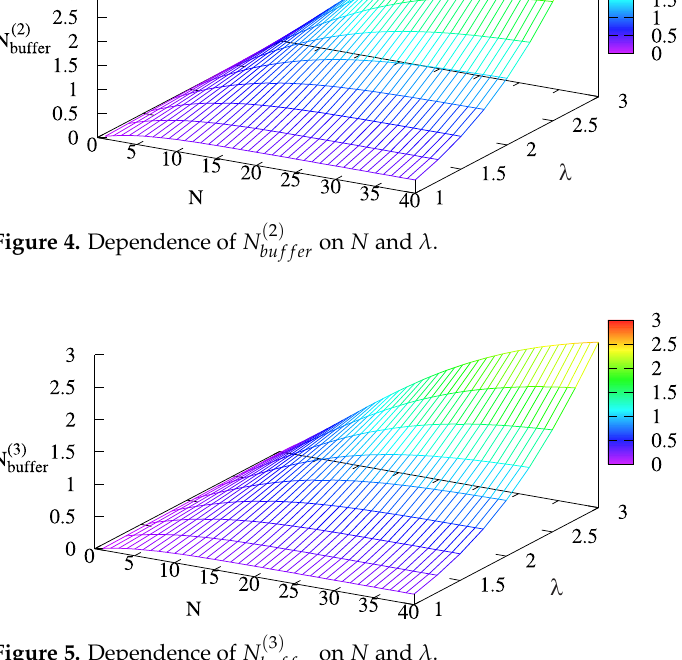
( 3 ) on N and λ buf fer